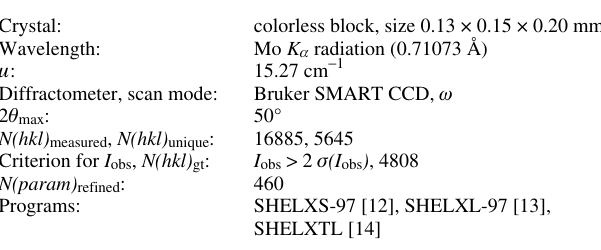
Table 1. Data collection and